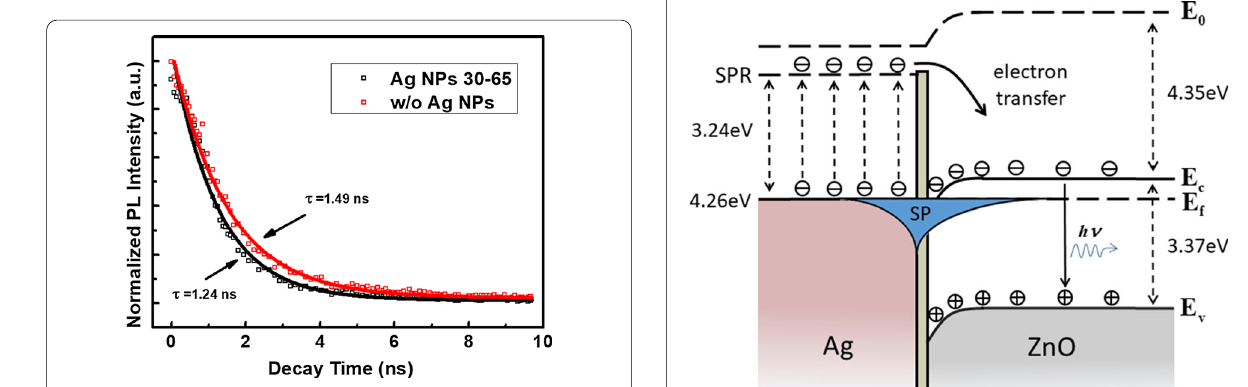
Fig. 5 Time‑resolved PL decays of sample 1 without Ag NP arrays and sample 2 with Ag NP arrays at 380 nm Fig. 6 Schematic energy band diagram of Ag/Al